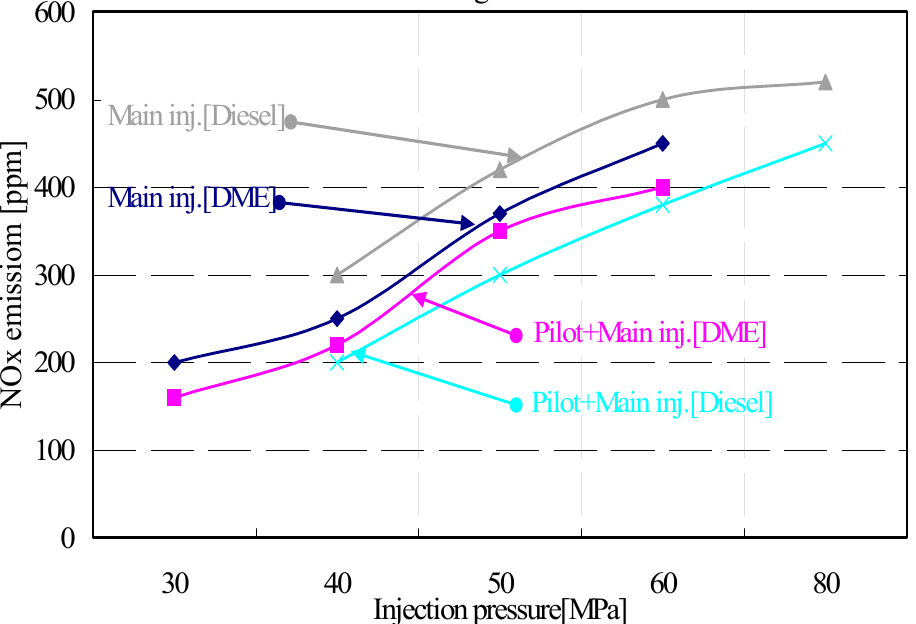
Figure 8. NO x emission characteristics of diesel and DME engines with and without pilot injection as a function of injection pressure.